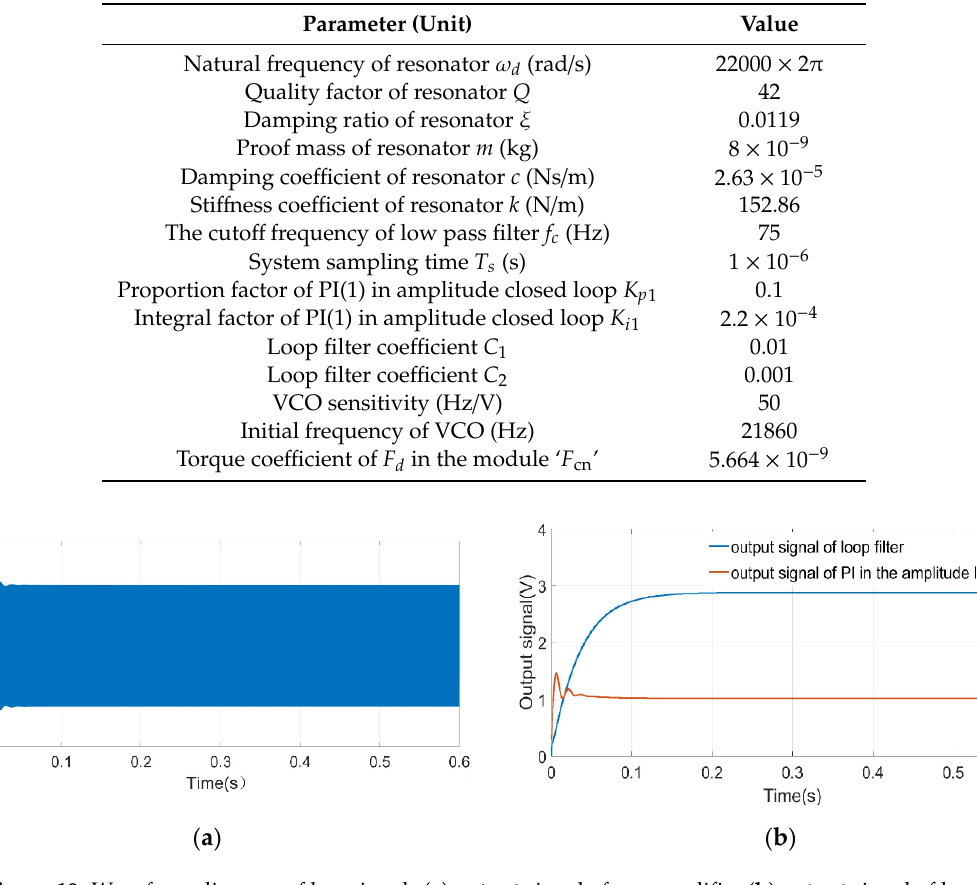
Figure 10. Waveform diagram of key signals ( a ) output signal of pre-amplifier ( b ) output signal of loop filter and output signal of PI in the amplitude loop